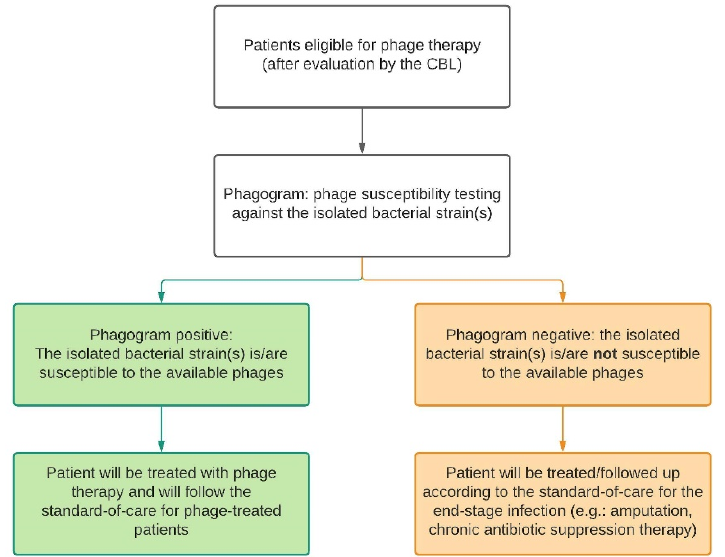
Figure 2. Depending on the result of the phagogram, the patient will follow either the phage therapy trajectory (green) or the control trajectory (orange). For each trajectory, there is a standard-of-care protocol. CBL: Coordination group for Bacteriophage therapy Leuven.